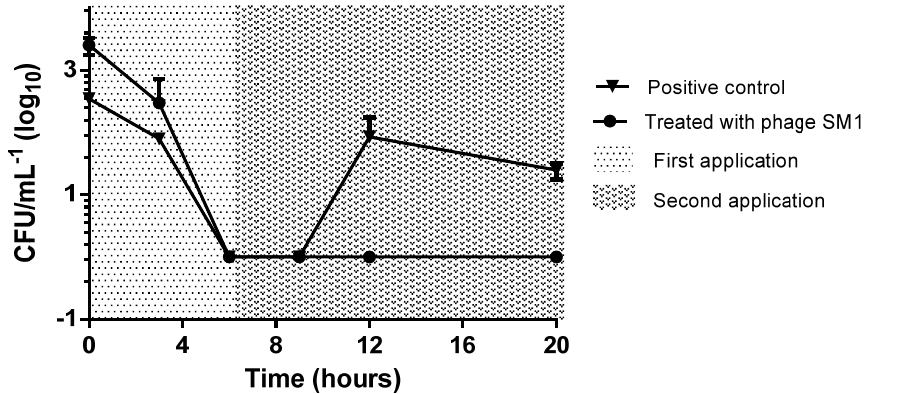
Figure 4. Efficacy of two sequent applications of phage SM1 for S. e. Enteritidis reduction on poultry litter. The positive S. e. Enteritidis control is presented by triangles, indicating the S. e. Enteritidis colonies enumeration on poultry litter without phage SM1 addition.